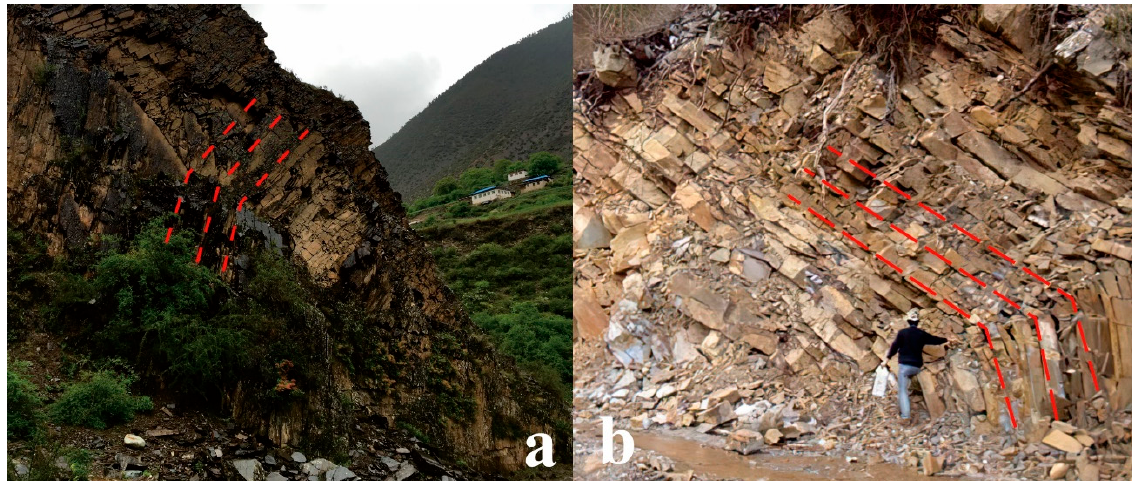
Figure 1. Typical toppling deformation slope, ( a ) The toppling slope of the Yuqu River Zhala Hydropower Station, ( b ) The toppling slope on the left bank of Wulongnong Hydropower Station.